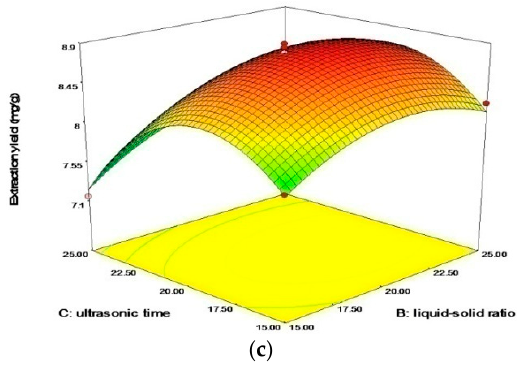
Figure 4. The plots for 3D response surface revealed the effect of ( a ) IL concentration and liquid/solid ratio; ( b ) IL concentration and ultrasonic time; ( c ) liquid/solid ratio and ultrasonic time on the extraction yields of total flavonoids.